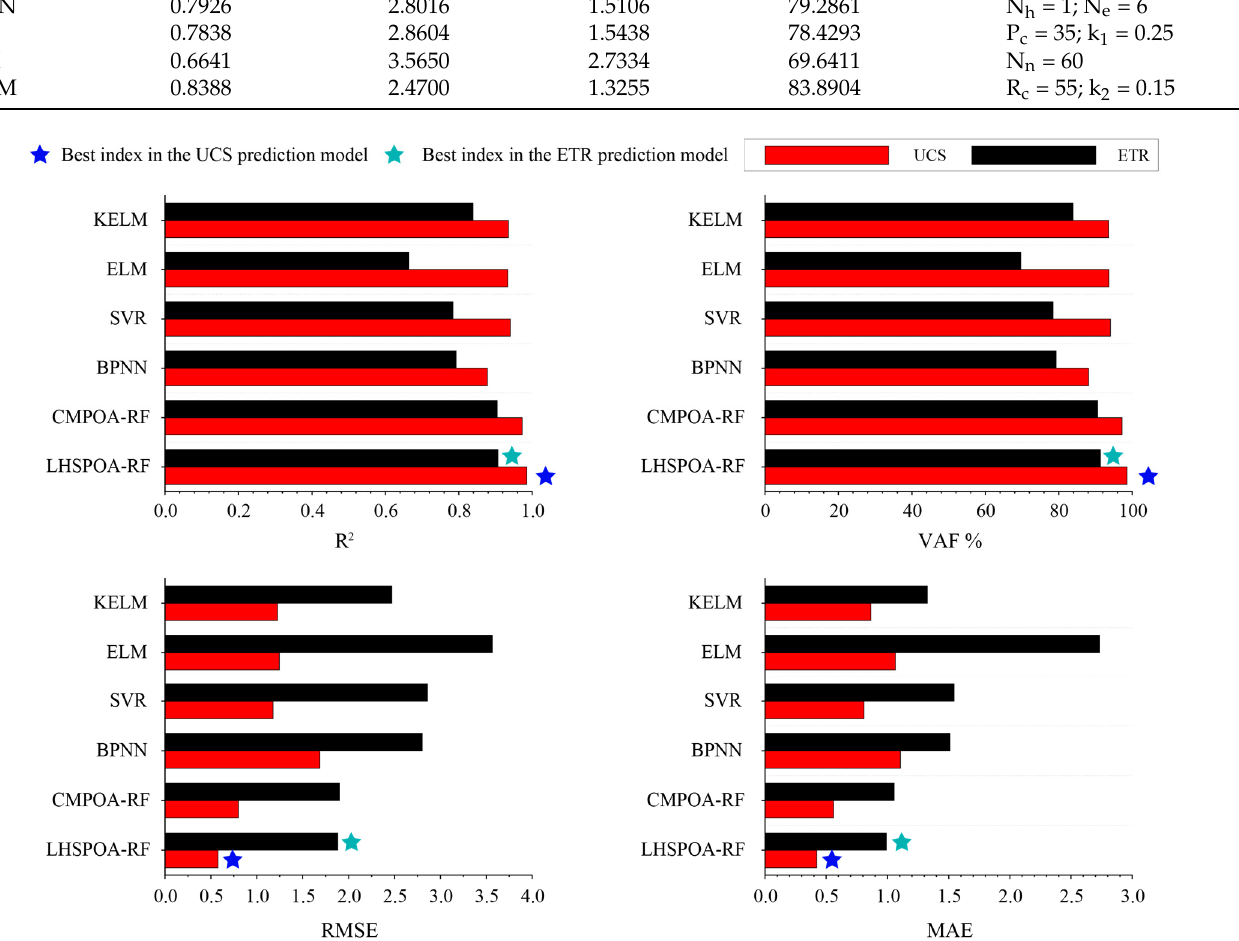
Figure 8. The performance comparison of the proposed models and four common ML models in the UCS and the ETR prediction.